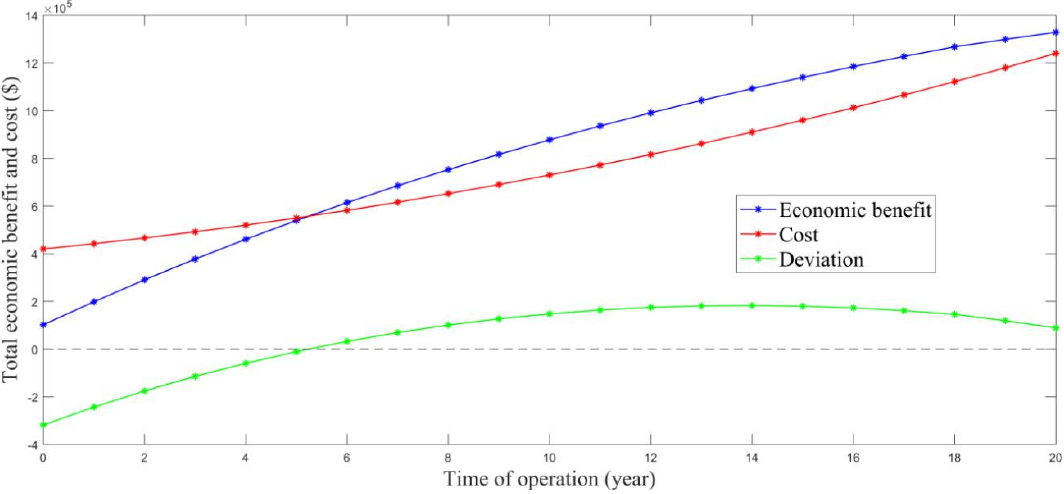
Figure 11. Total economic benefit and cost over year.